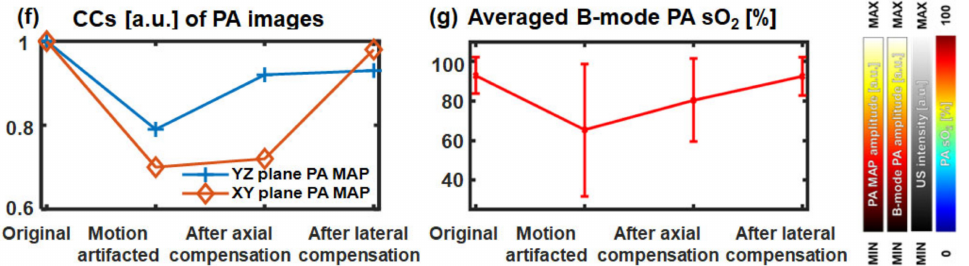
Figure 4. In vivo 3D multispectral PA/US imaging of a human wrist. ( a ) Photograph of the human wrist. The red dashed boxes represent the imaged regions. ( b ) Original and ( c ) artificially motion- disrupted photoacoustic (PA) maximum amplitude projection (MAP) images on the YZ and XY planes of the human wrist. The PA MAP images on the YZ and XY planes after ( d ) axial and ( e ) lateral motion correction. The X, Y, and Z directions represent lateral, elevational, and axial directions, respectively. B-mode US/PA and B-mode US/PA sO 2 images of the human wrist are presented. The PA and PA sO 2 images of the upper boundaries of radial arteries (RAs) are overlaid on the corresponding US images. White dashed lines in the MAP images correspond to B-mode US/PA and B-mode US/PA sO 2 image positions. ( f ) The cross-correlations (CCs) between the original PA images and others. ( g ) The average PA sO 2 values in the RAs. sO 2 : haemoglobin oxygen